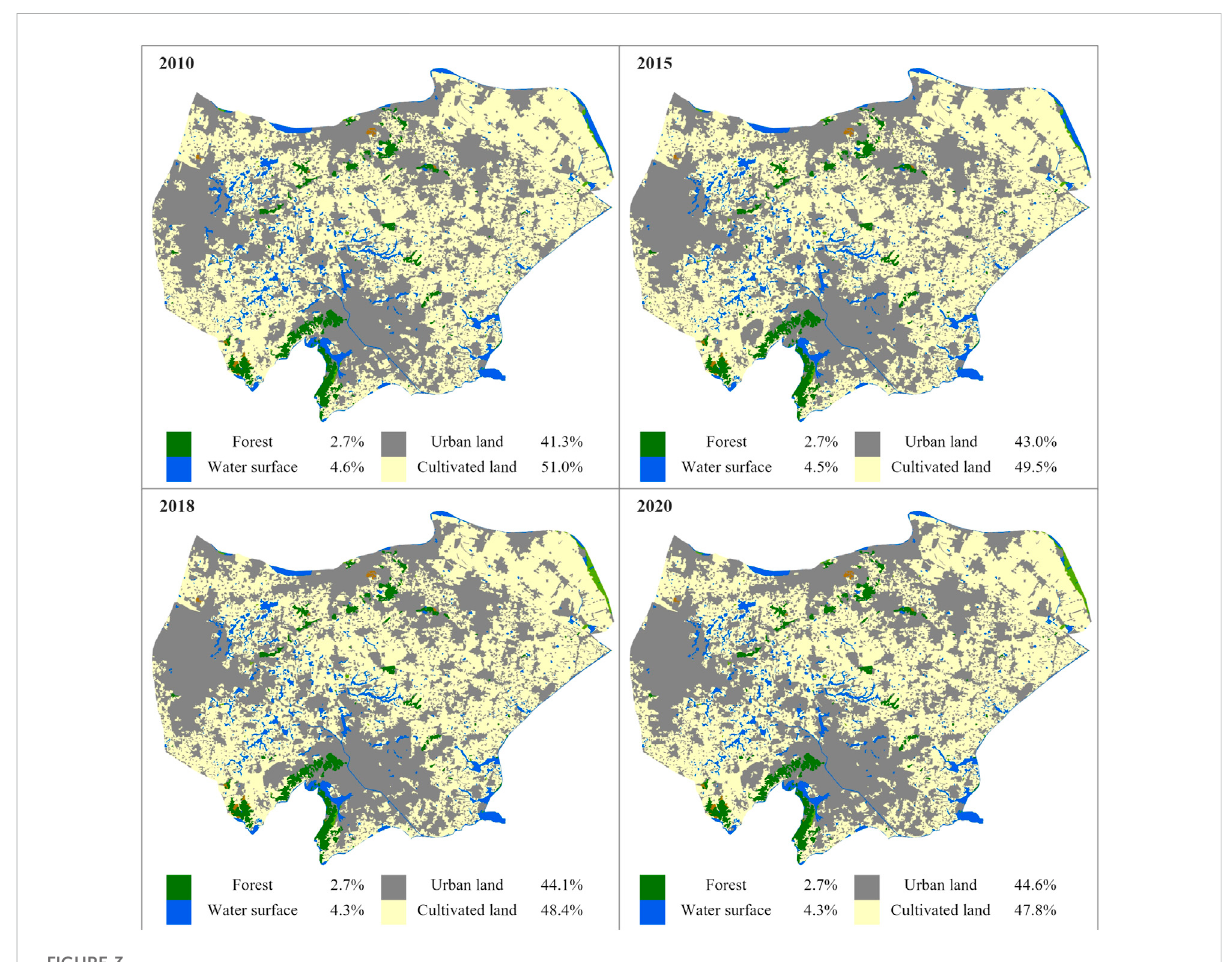
FIGURE 3 Main land cover of the Wuchengxiyu region in 2010, 2015, 2018, and 2020 (CNLUCC data with 30 m resolution, taken from the Institute of Geographic Science and Natural Resources